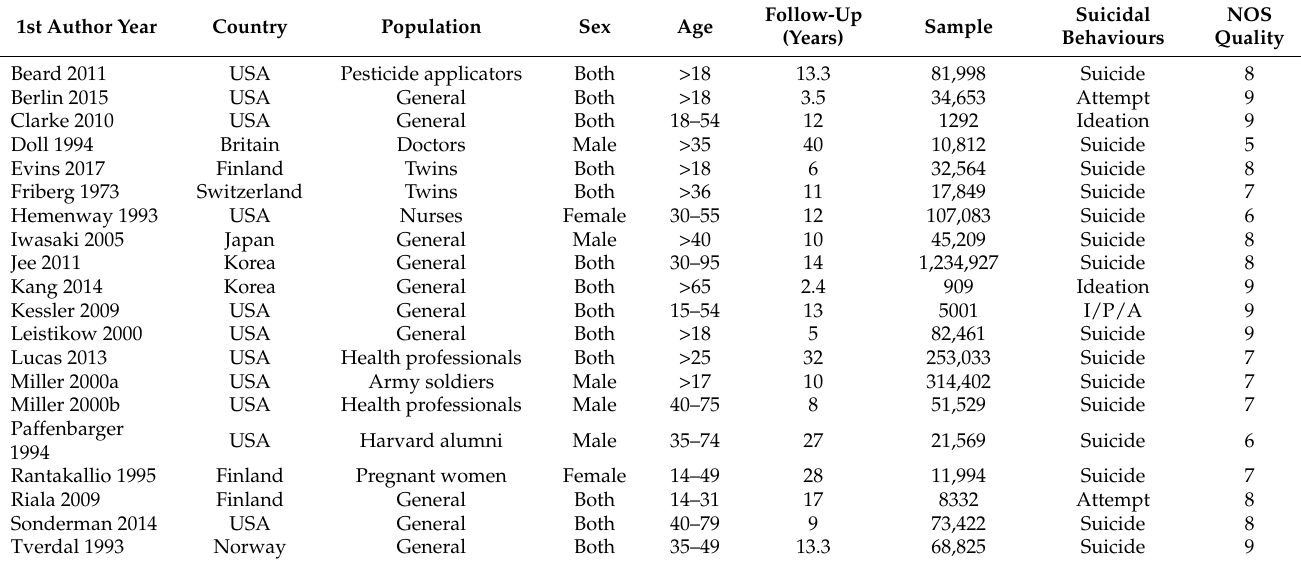
Table 1. Studies included [15–34].